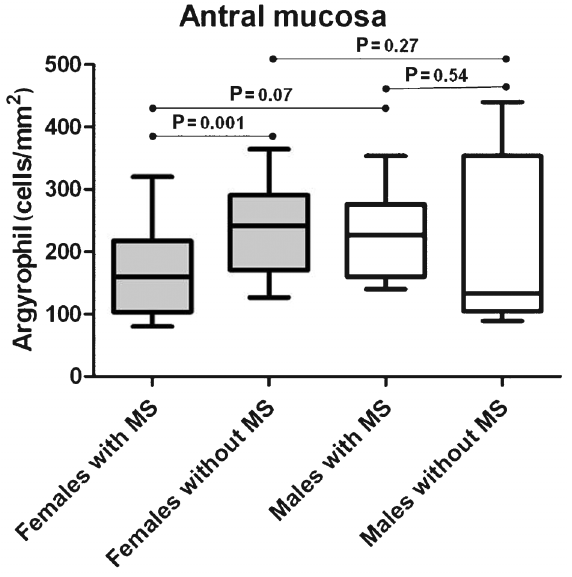
Figure 3. Argyrophil cell density in the antropyloric mucosa of female and male morbidly obese patients with and without metabolic syndrome